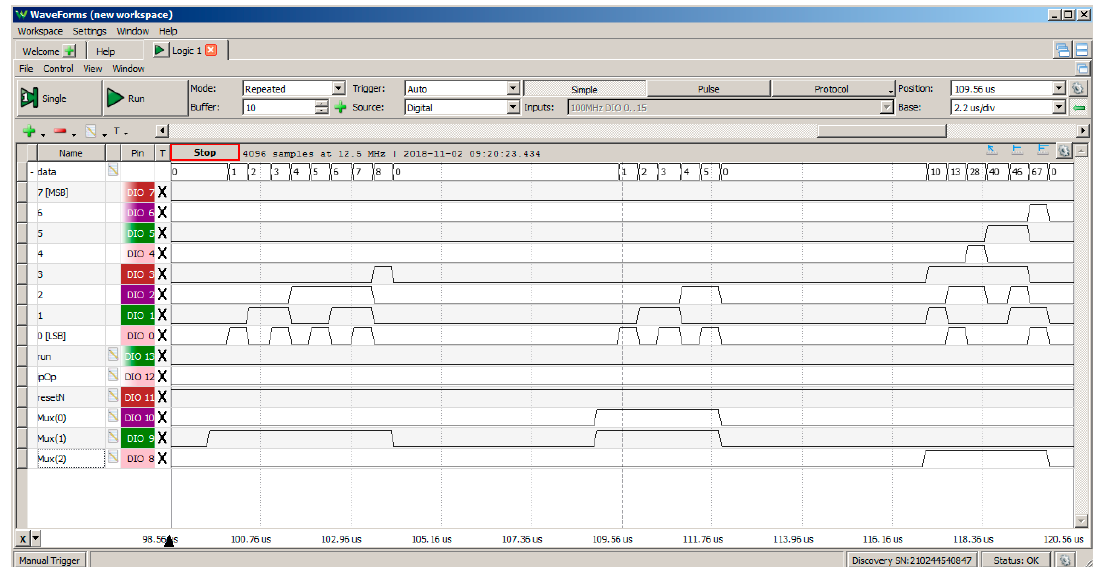
Figure 16. Logic analyzer test results using the Digilent ® Analog Discovery: Data readout.